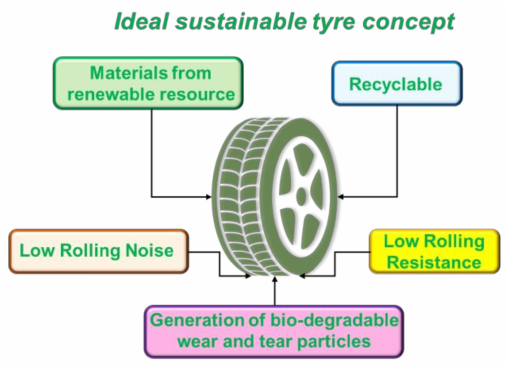
Figure 1. Proposal of an ideal sustainable tyre concept.